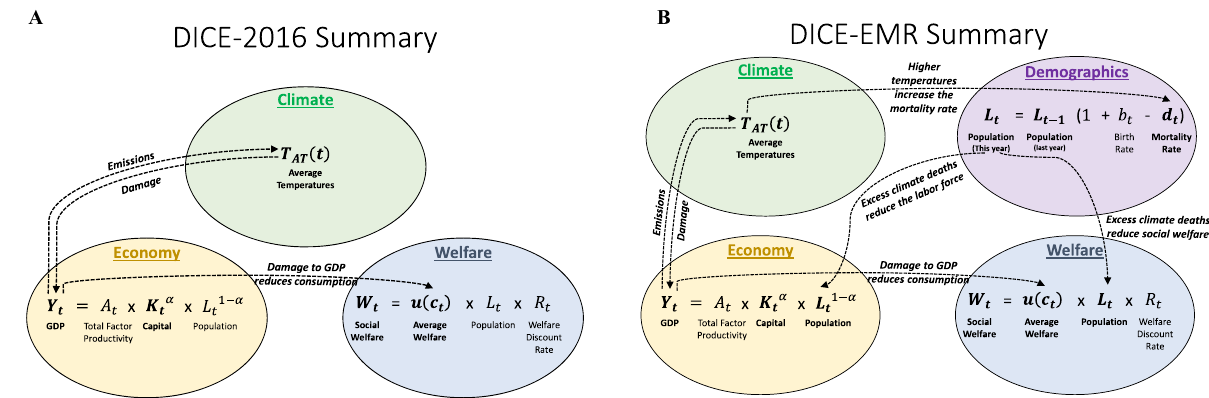
Fig. 5 A summary of the DICE-2016 and DICE-EMR integrated assessment models (IAMs). Endogenous components (determined by the model) are in bold. Exogenous components (inputs to the model) are not bold. A is a summary of the DICE-2016 model. In this model, the economy affects the climate through emissions and climate only affects society through the damage function that reduces GDP. Our review of 8 — the review study that constructs the DICE-2016 damage function — concludes that mortality costs account for <5% of the damages in the damage function. B is a summary of the DICE-EMR model. DICE-EMR takes the rest of DICE-2016 as given and adds a fourth system: demographics. The climate affects the mortality rate through the mortality damage function, which is estimated by a systematic research synthesis of the scholarly literature. This directly reduces welfare due to the welfare cost of these excess deaths, and this effect is calibrated to estimates for value of a statistical life